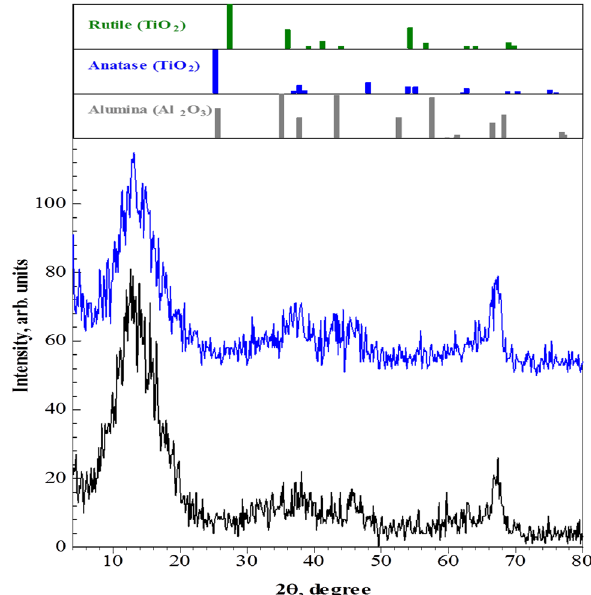
Fig. 3 a , b XRD of bar alumina disc and TiO